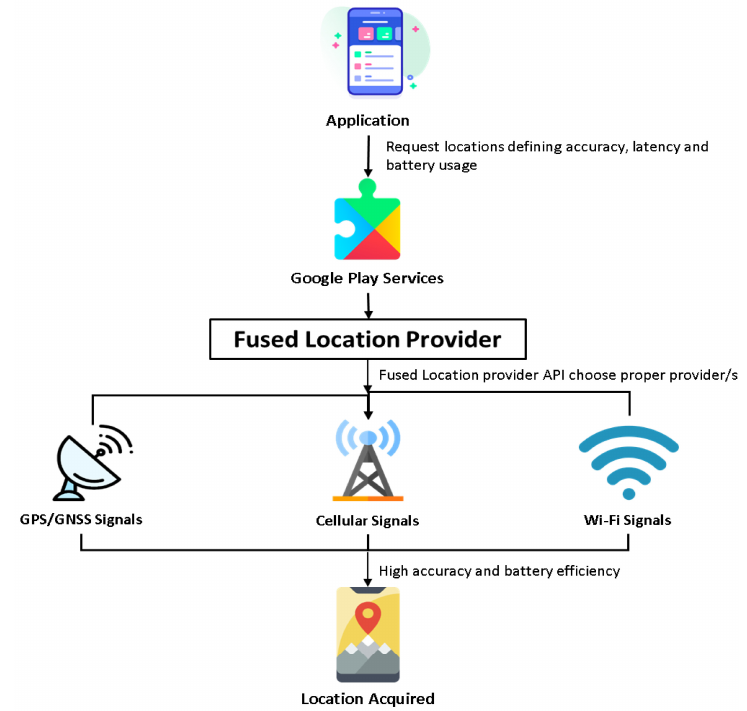
Figure 6. Location Provider API